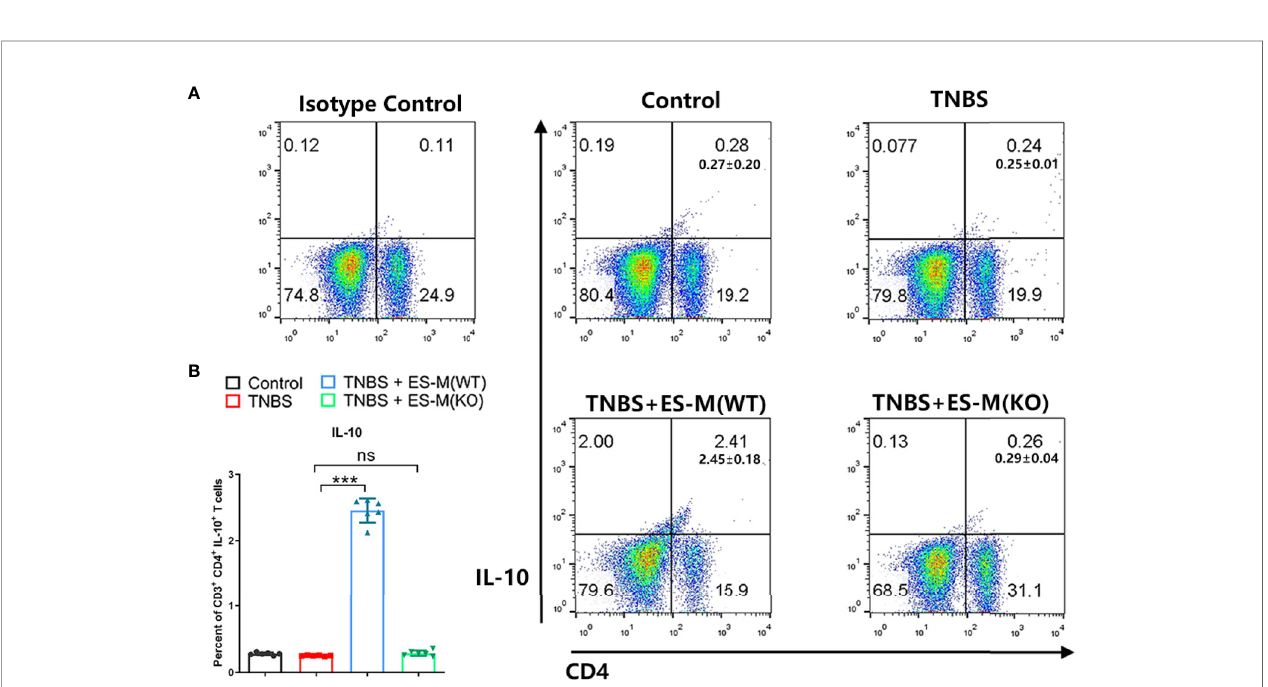
FIGURE 6 | Differentiation of CD3 + CD4 + IL-10 + T cells of T. spiralis ES – induced wild type (WT) or Nrf2 KO macrophages (ES-M) on TNBS-induced colitis. (A) CD3 + T cells were gated. CD4 + IL-10 + T cells populations were determined. (B) The percent of CD4 + IL-10 + T cells were shown. Data are shown as the means ± SD (three independent experiments) of each group (n=6). ***p < 0.001, ns, no signi fi cance, as indicated by line (one-way ANOVA with Tukey ’ s posttest). These fi gures are representative of three independent